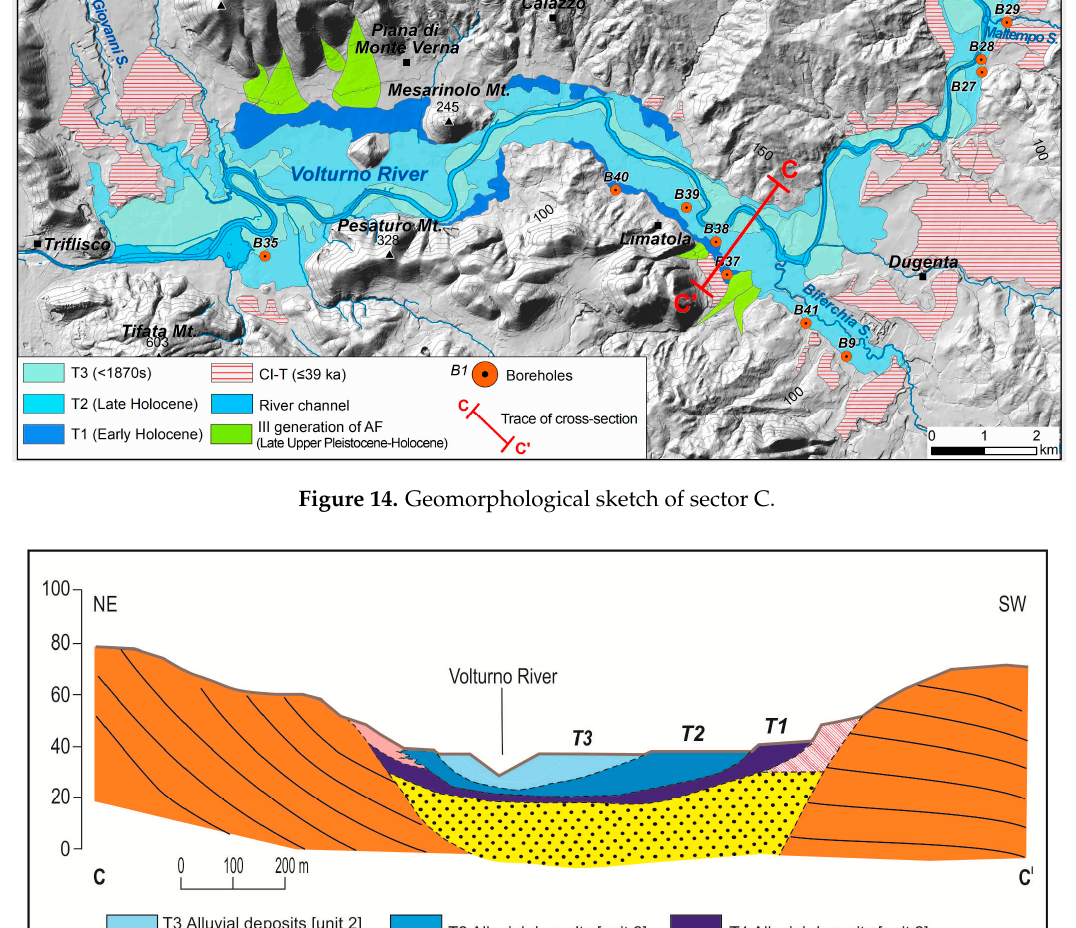
Figure 14. Geomorphological sketch of sector C.